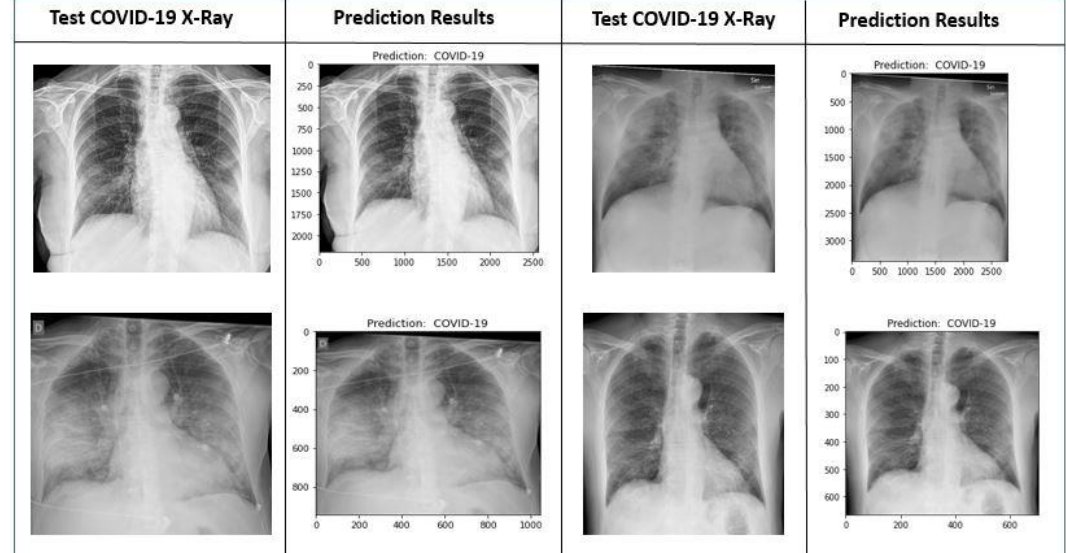
Figure 11. COVID-19 X-rays were tested output which produced by model are shown.